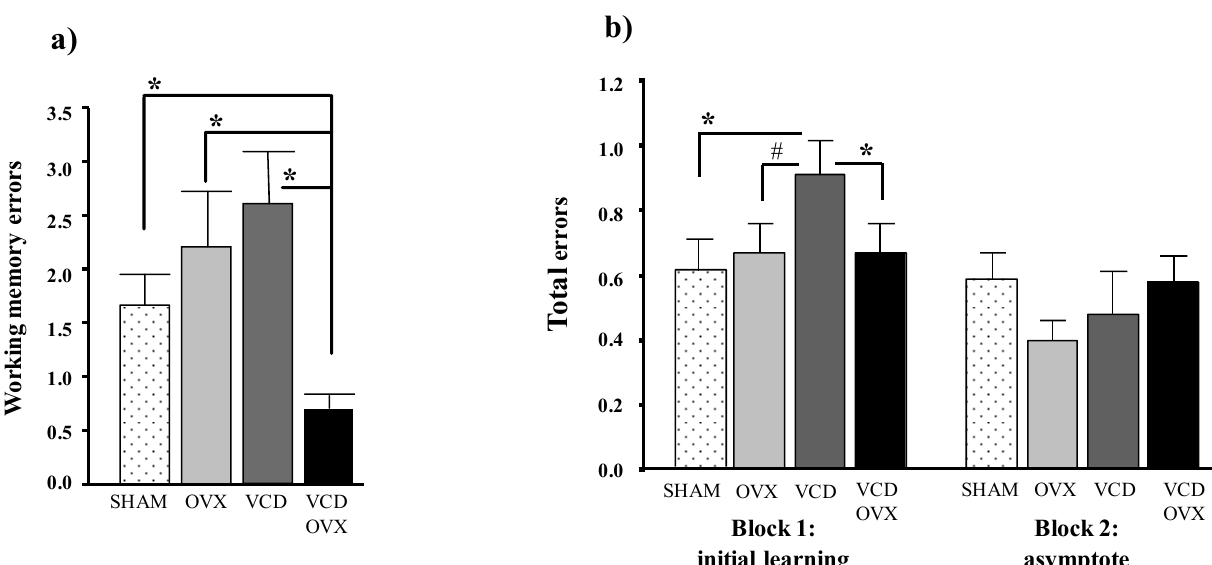
Figure 3. Spatial memory performance in several experimentally-induced forms of ovarian hormone loss, VCD-induced follicular depletion (gradual, transitional menopause) and Ovx (surgical menopause), in the middle-aged rat [87]. Also included was a group that received VCD followed by Ovx to model transitional menopause followed by surgical menopause, thereby removing residual hormones released from the follicle deplete ovary. a) After water radial-arm maze initial testing, a 4-hr delay between trials 2 and 3 was imposed. The graph depicts mean ± SE spatial working memory errors for each group for post-delay trials. The VCD-Ovx group made fewer errors relative to all groups, suggesting that transitional ovarian hormone loss before Ovx aids memory retention, and that removal of residual ovarian tissue after transitional ovarian hormone loss improves memory retention relative to retaining residual ovarian tissue, * p < 0.0005. b) Initial baseline performance on the delayed-match-to-sample spatial recent memory task. Trial 1 was the information trial, informing the animal where the platform was located on that test day. Shown are the mean±SE errors for each group for blocks 1 and 2 for the test trials. SHAM and VCD-Ovx groups made fewer errors during initial learning in block 1, relative to the VCD group, * p < 0.05, suggesting that transitional menopause without Ovx impaired performance, while Ovx initiated after the transition enhanced performance. The Ovx group was marginally different from the VCD group, # p =